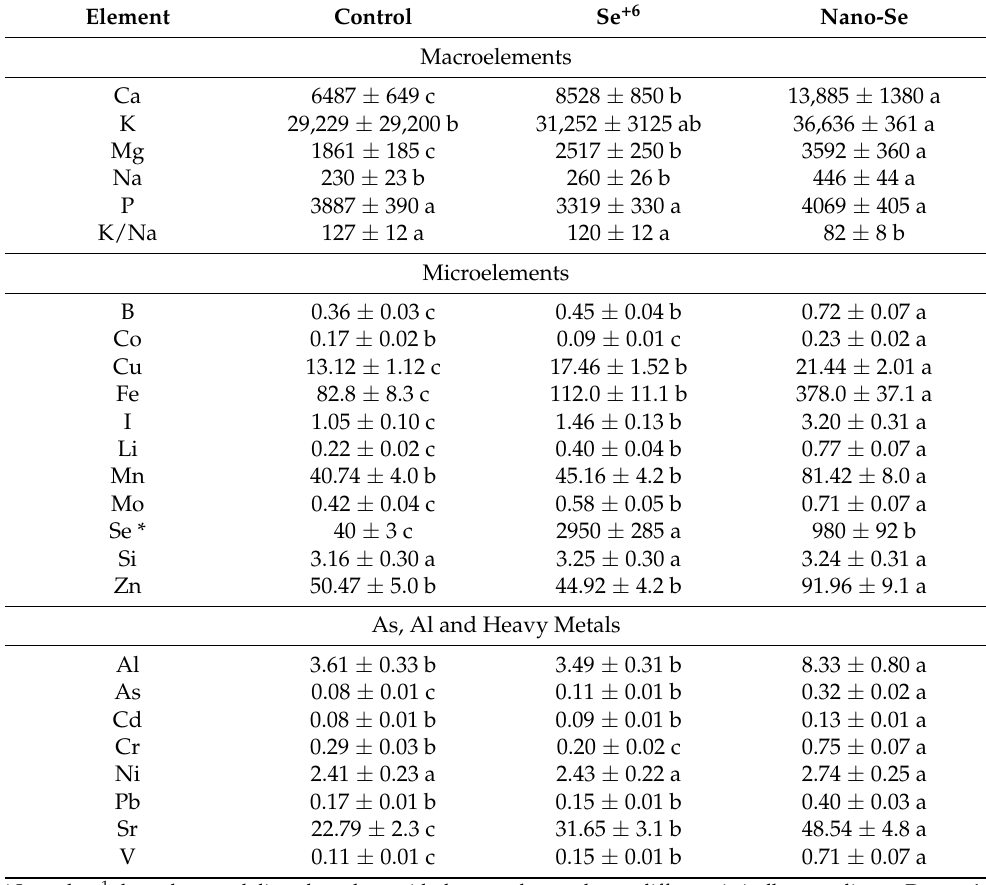
Table 6. Elemental composition of A. annua leaves as affected by sodium selenate and nano-Se (mg kg − 1